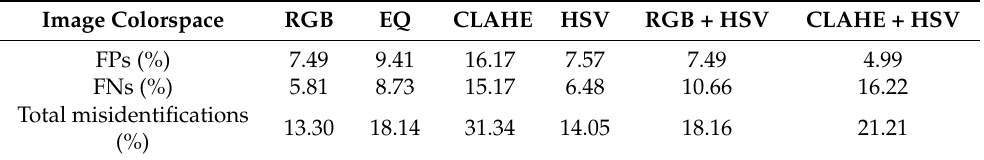
Table 4. Overall performance evaluation, expressed as percentages (%), of the models examined in the test set of the study, in terms of false positives (FPs), false negatives (FNs), and their sum ratios over the total number of trees in the test set.